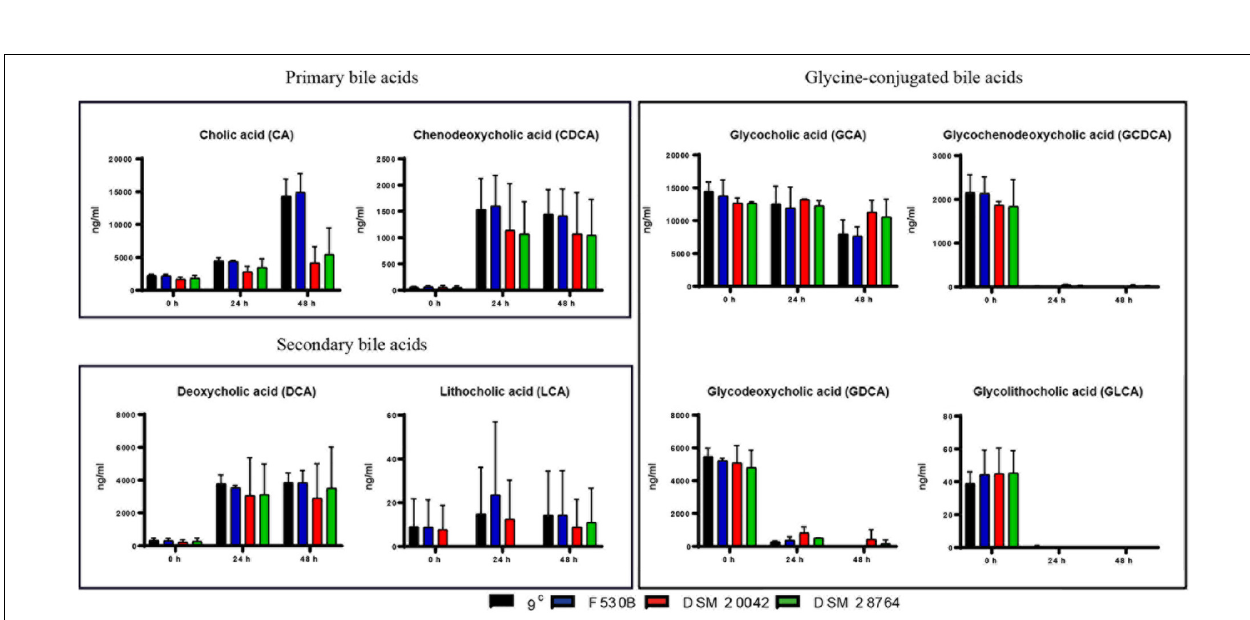
FIGURE 3 | Growth curves in aerobic and anaerobic conditions, with and without bile, of stool isolates ( S. epidermidis 9 c and F530B), skin isolates ( S. epidermidis DSM 20042 and DSM 28764), sepsis-related S. epidermidis RP62A and non-infection related S. epidermidis ATCC 12228, E. coli ATCC 25922 for negative control and L. reuteri NCIMB 30242 with bile salt hydrolase activity for positive control. Results are the mean of three replicates ± standard deviation.